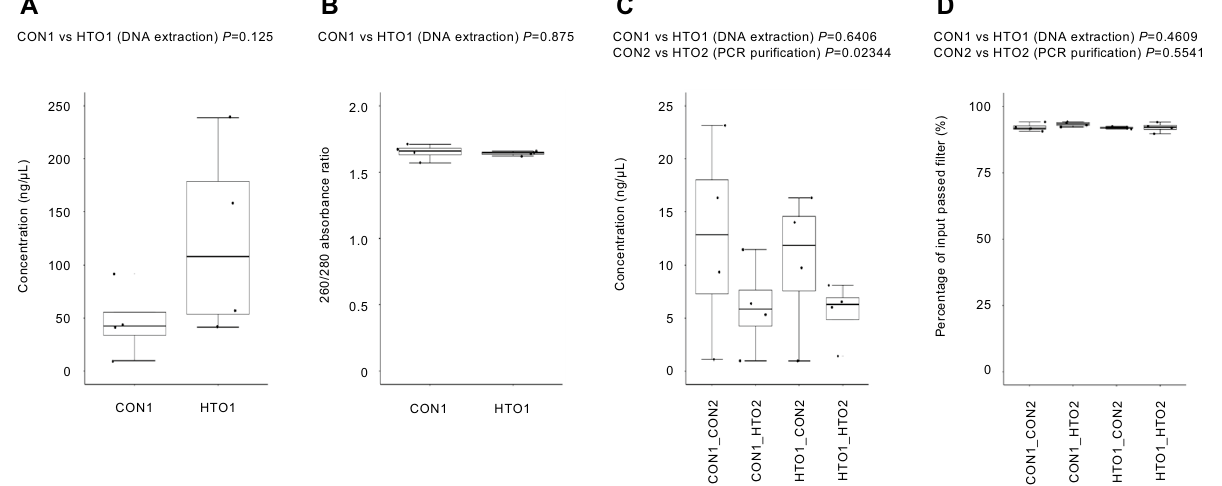
Figure 2. Yield and quality of DNA extraction and library preparation among different methods. The yield (ng/μL) ( A ) and quality (260/280 absorbance ratio) of nucleic acid ( B ) are shown for the AMPure XP bead and isopropanol methods. The concentration of the library (ng/µL) ( C ) and reads passing set quality filter (%) ( D ) are shown for all methods described in Fig. The raw paired-end FASTQ files were imported into the QIIME2 program and demultiplexed using a native plugin. Thereafter, the Cutadapt plugin was processed primer trimmed. The Divisive Amplicon Denoising Algo- rithm 2 (DADA2) plugin in QIIME2 was used for quality filtering. The demultiplexed FASTQ file was trimmed, de-noised, the chimera was removed, and the data were merged 41 . We applied the parameter with truncation length of 220 for both forward and reverse reads. Taxonomic groups were assigned identity with the Naive Bayes q2-feature-classifier trained using the 515F/806R region from 99% operational taxonomic units (OTUs) from the SILVA 138 rRNA database 42,43 . Contaminating archaeal, eukaryotic, mitochondrial, and chloroplast sequences were filtered out of the resulting feature table. After taxonomic assignment of amplicon sequence variants (ASVs), the remaining representative sequences were aligned with MAFFT and used for phylogenetic reconstruction in IQ-TREE multicore version 2.0.3 44 . The sampling depth parameter were set to 1,181 (HTO1/2 vs. CON1/2, Supplementary Dataset 1) and 2,988 (HTO1_HTO2 vs. KIT1/2_CON2, Supplementary Dataset 2), which were chosen based on the number of sequences in the sample containing lowest number of sequences